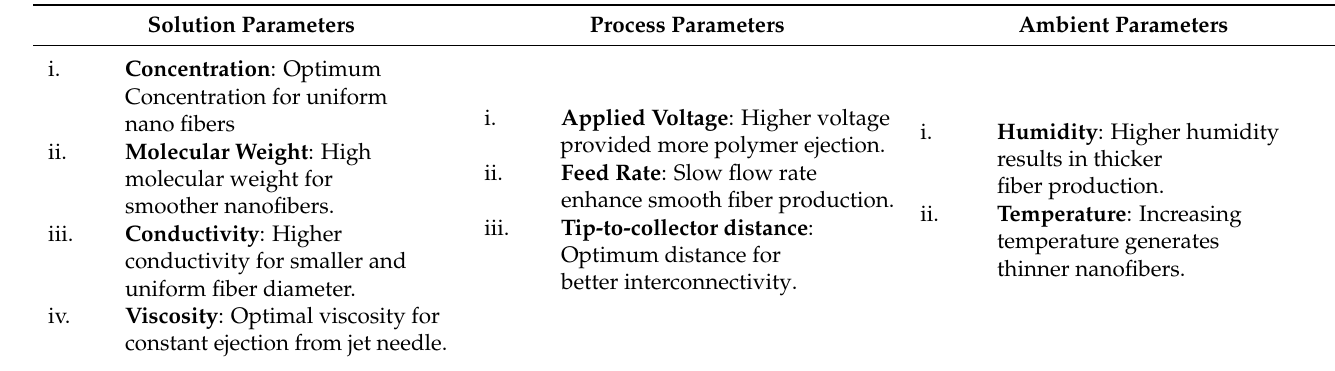
Table 2. Electrospinning Process Parameters